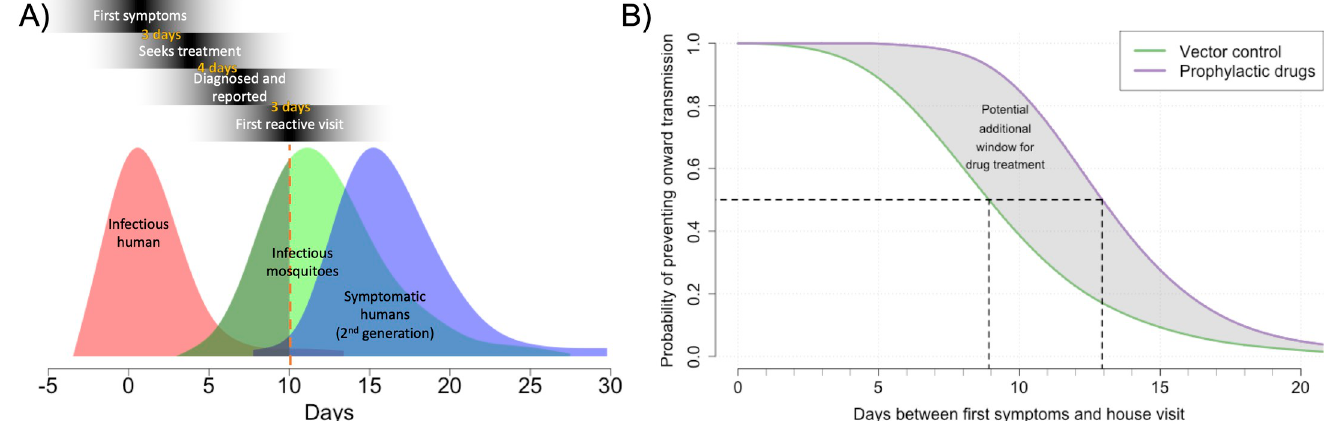
Fig 2. Probability of interrupting a single chain of transmission over time. A) the probability distribution of infectious humans, the mosquitoes they infect and the subsequent human dengue cases. The red dotted line shows a typical reactive delay. Day 0 is the day of first symptoms due to dengue. B) Probability of interrupting transmission over different delay durations. Black dotted lines show the time when there is a 50% chance of interrupting transmission.